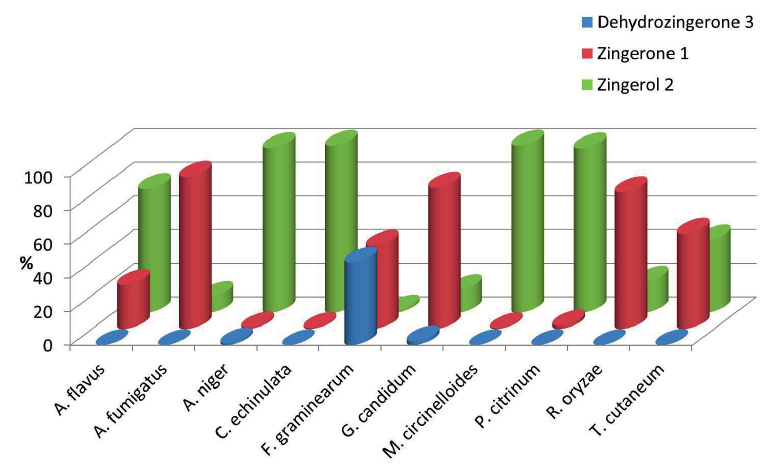
Figure 1. Biotransformation of dehydrozingerone 3 with ten different filamentous fungi during 72 h. The percentages (%) of each product zingerone 1 or zingerol 2 are showed in different rows. The front row shows the percentage of the remainder substrate 3 in each biotransformation process .